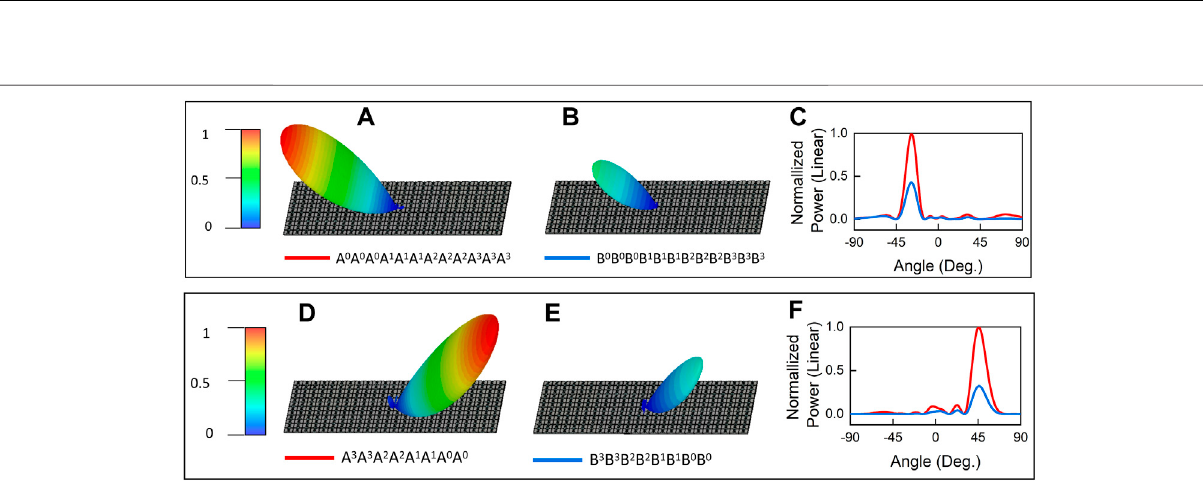
FIGURE 5 | The re fl ection coef fi cients on the complex plane at incident angles of (A) 0 ° (B) 30 ° , and (C) 60 ° . Stable amplitude and phase responses are obtained due to the introduction of the numerous metallic vias at 3 GHz.